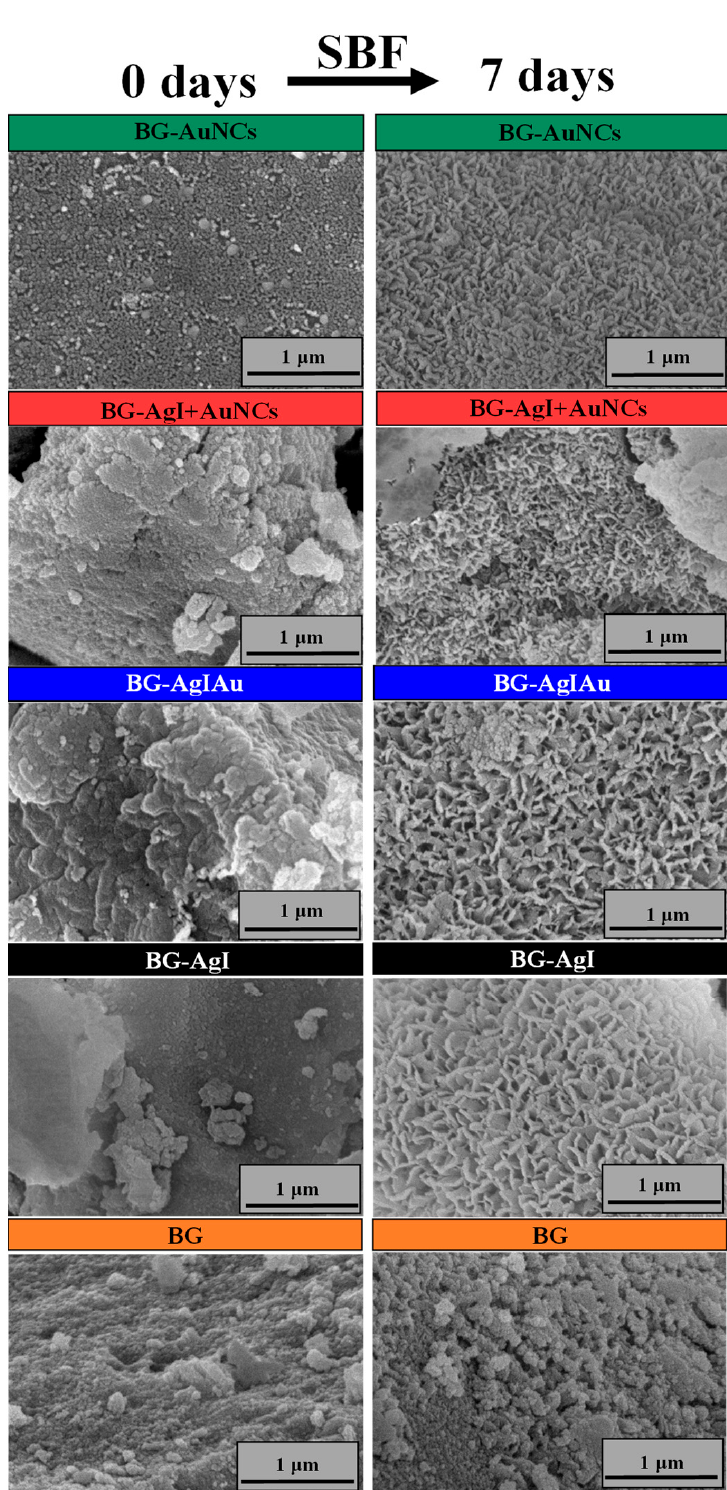
Figure 6. SEM micrographs BG, BG-AgI, BG-AgIAu, BG-AgI+AuNCs, and BG-AuNCs before (0 days) and after (7 days) immersion in SBF.